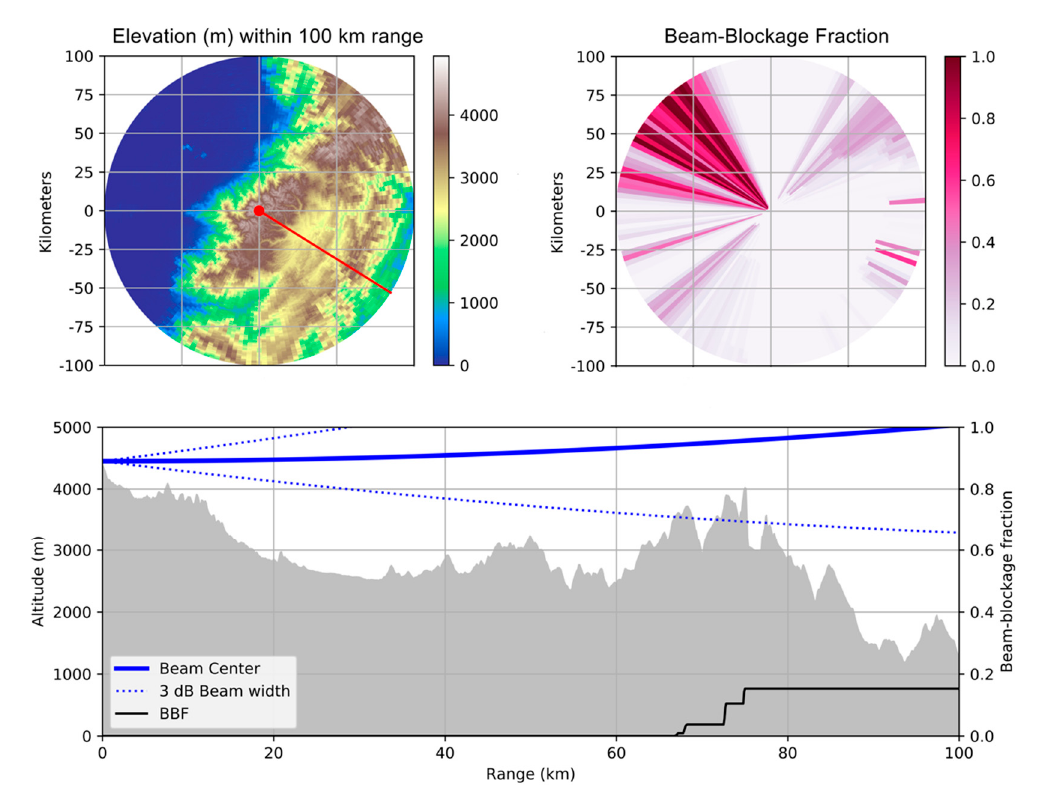
Figure 2. Beam-blockage fraction (BBF) calculated for the CAXX coverage. Transversal section for azimuth 122 (Balzay station location) is illustrated. The grey shaded area depicts the elevation of the terrain.